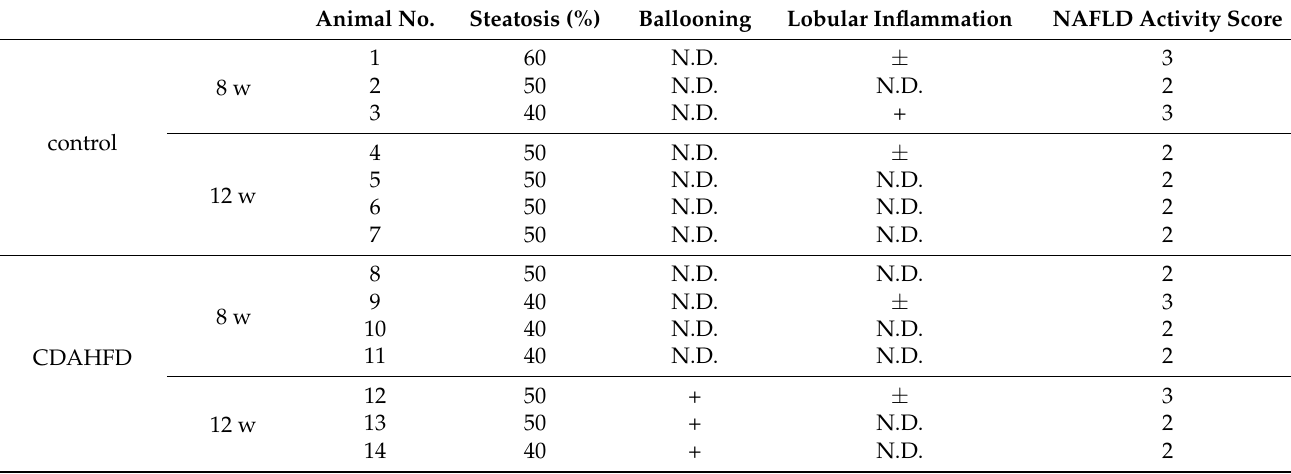
Table 1. NAFLD activity score in chimeric mouse livers fed a control diet and CDAHFD for 8 and 12 weeks. Animal No. Steatosis (%) Ballooning Lobular Inflammation NAFLD Activity Score 1 60 N.D. ± 3 50 N.D. N.D. 8 w control